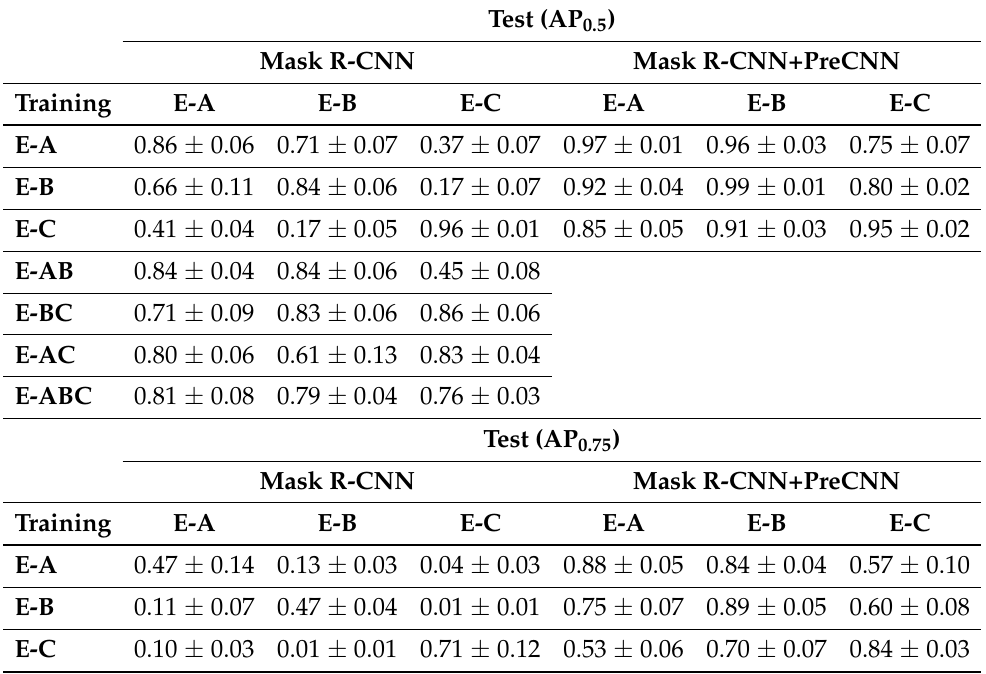
Table 2. The AP 0.5 and AP 0.75 of Mask R-CNN and Mask